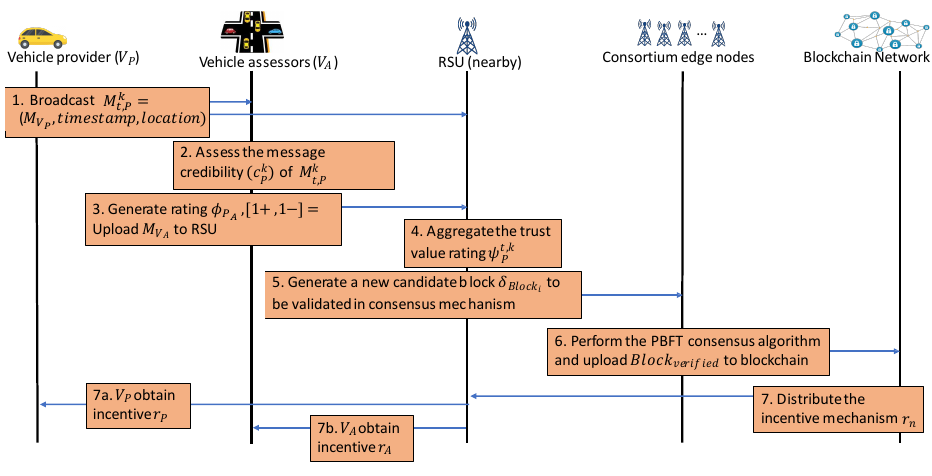
Figure 5. Workflow summary of blockchain-based data sharing management system on Internet of Vehicles edge computing